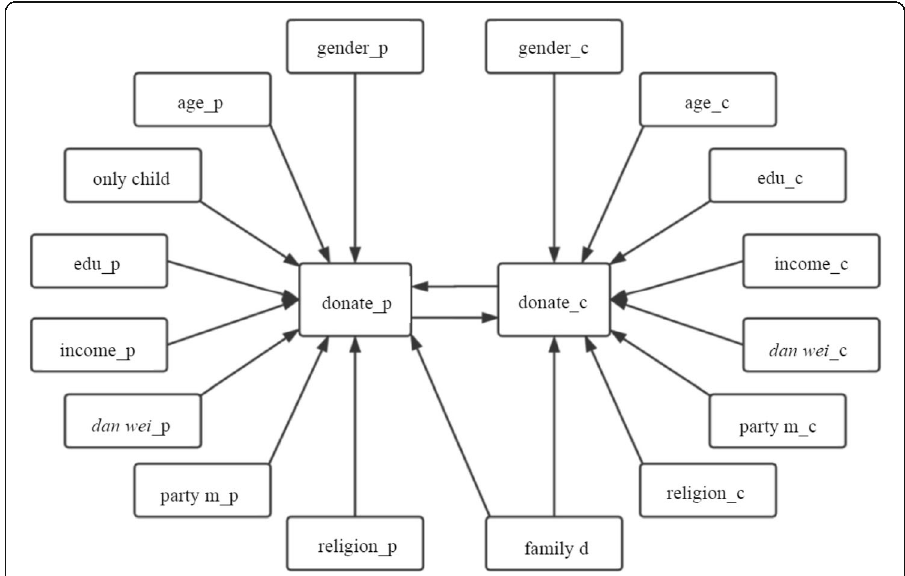
Fig. 2 Diagram of the non-recursive model. Note: “ _p ” represents parentage, “ _c ” represents children, “ family d ” denotes donation in the name of the family, “ edu ” denotes education, and “ party m ” denotes party